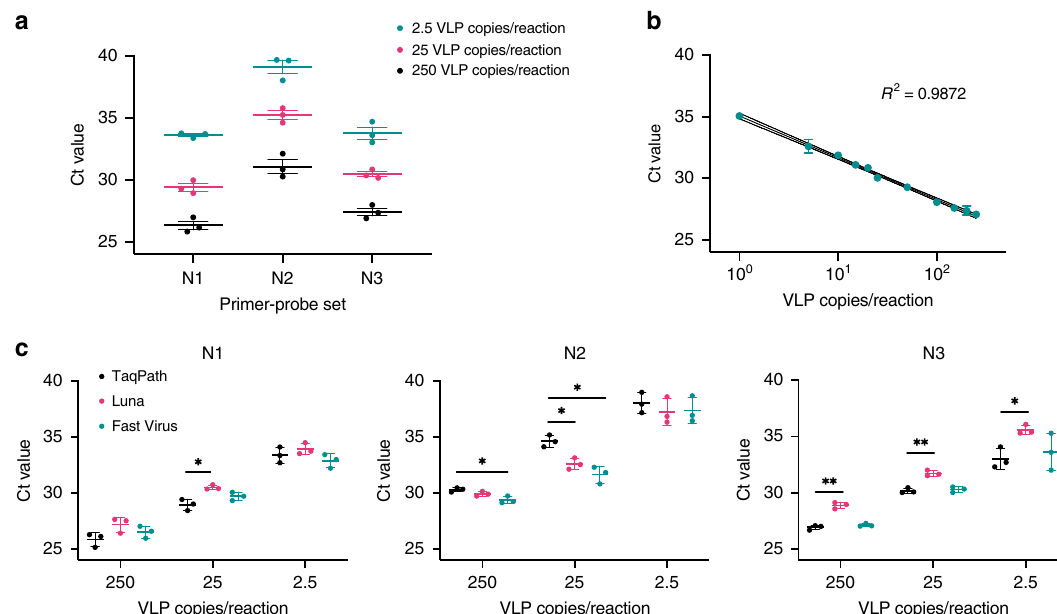
Fig. 2 MS2-SARS-CoV-2 VLP detection with multiple target primer – probe sets and qPCR master mixes. a VLP dilutions of 2.5, 25, and 250 copies per reaction were analysed by one-step RT-qPCR using the CDC primer – probe sets N1, N2, and N3 with the TaqPath master mix (Thermo Fisher Scienti fi c) and reported as Ct values. b A Ct value standard curve for VLP concentrations of 1, 5, 10, 15, 20, 25, 50, 100, 150, 200, and 250 VLP copies per reaction was determined using the N1 primer – probe set and the TaqPath master mix. c VLP dilutions of 250, 25, and 2.5 copies per reaction were analysed using the TaqPath, Luna Universal (NEB), and Fast Virus (Thermo Fisher Scienti fi c) RT-qPCR master mixes with the N1, N2, and N3 CDC primer – probe sets. All measurements in a and c are reported as mean ± SE of n = 3 independent experiments with three technical replicates. Measurements in b are reported as mean ± SD and are representative of n = 2 independent experiments with three technical replicates. Statistical difference between the TaqPath and Luna, as well as TaqPath and Fast Virus master mix Ct values was analysed using an unpaired two-sided t -test with (black star) indicating p < 0.05 and (double black star) p < 0.01. Source data are available in the Source Data fi